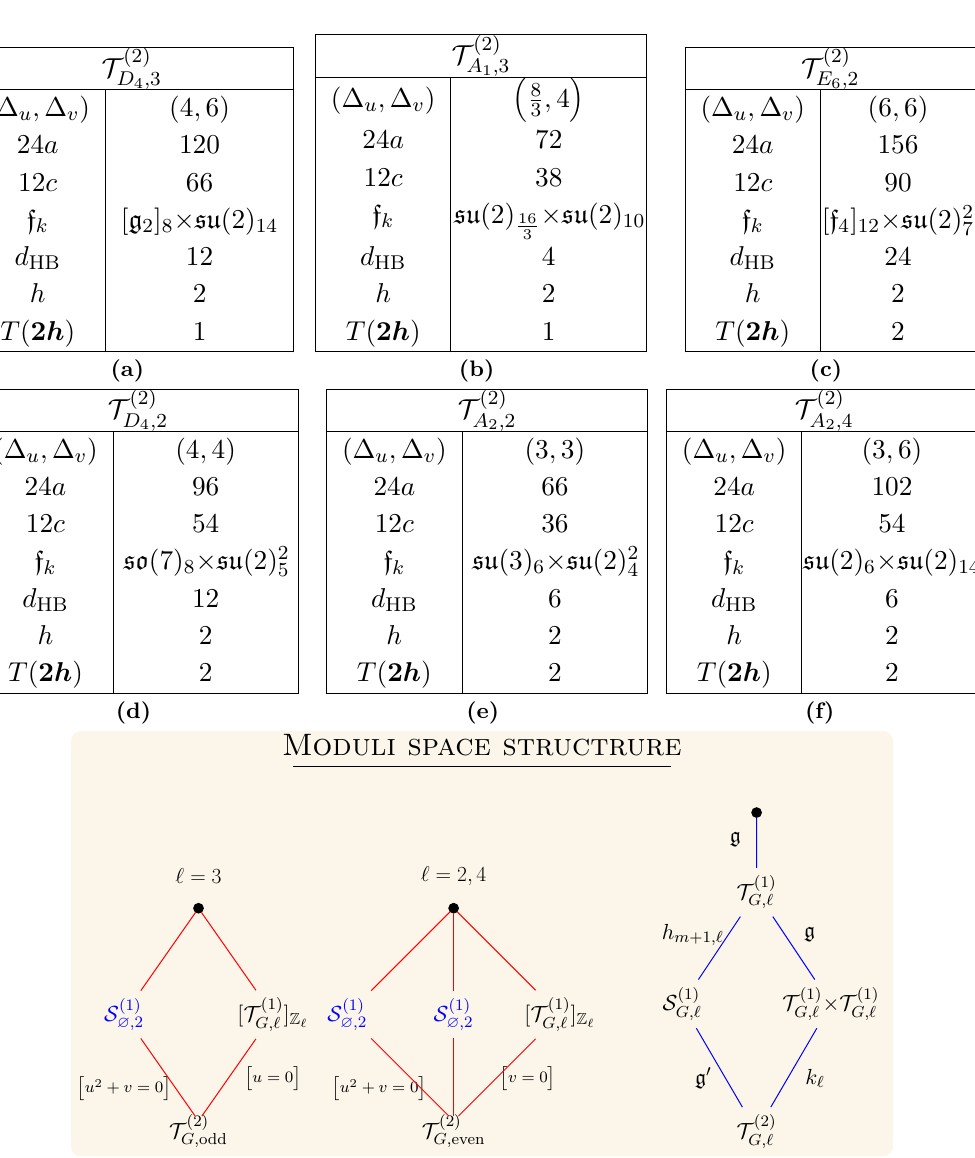
Figure 46. In this figure we report the relevant CFT data for the T (2) are equal to ( 4 , f ), ( 3 , g ), ( 2 , so (7) ), ( 2 , su (2) ), ( 1 , su (3) ) and ( 1 , su (2) ) for ( E 4 2 ( A 4) , ( A 2) and ( A 3) respectively and the k 2 , 2 , 1 ,